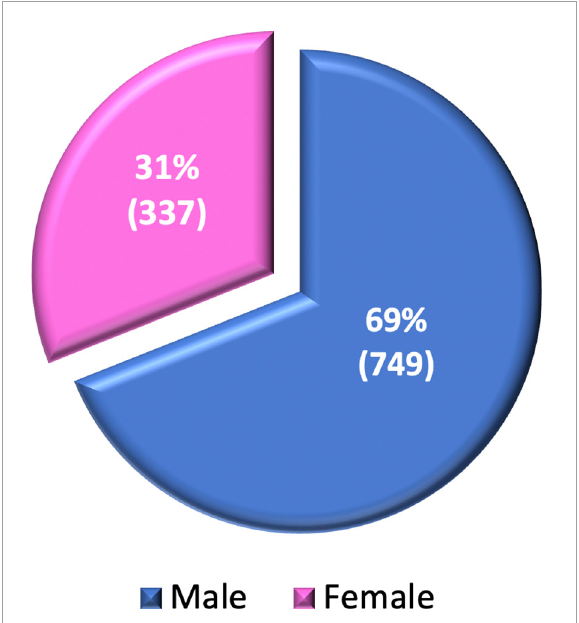
FIGURE1 Gender distribution of CMR surveyed